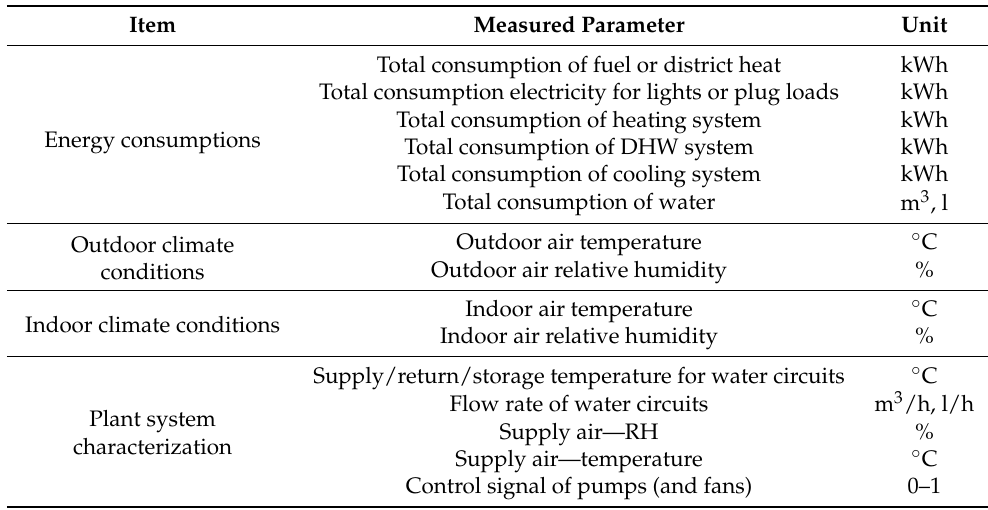
Table 2. Energy and environmental parameters and relative units. Item Measured